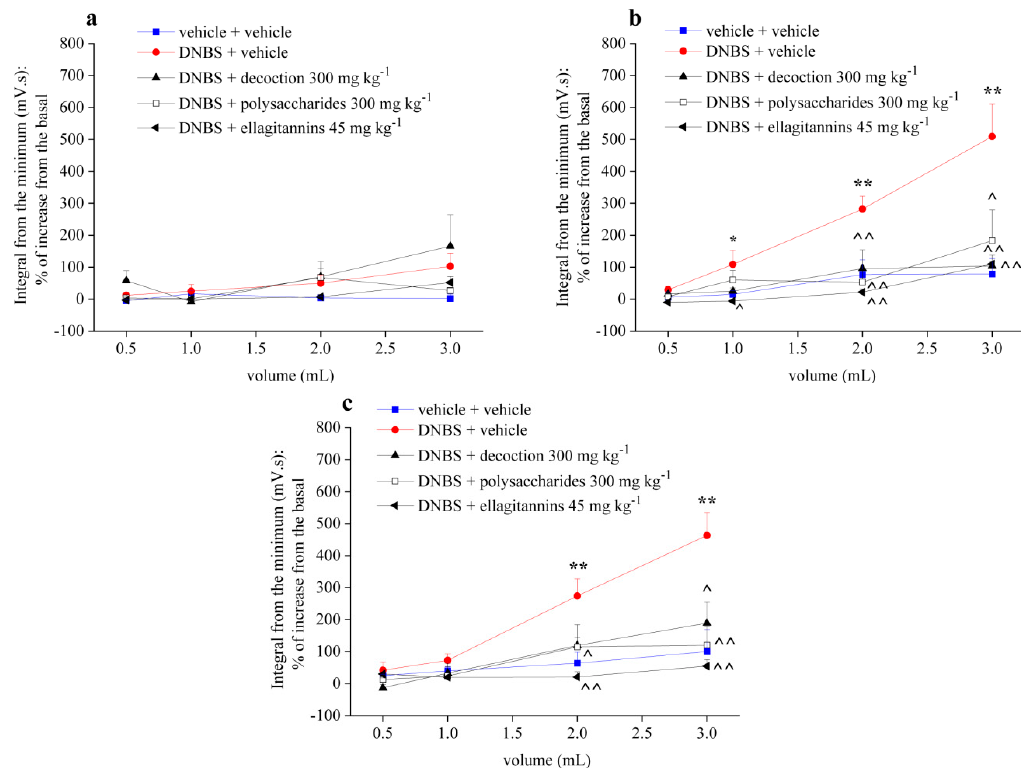
Figure 2. E ff ect of repeated treatment with pomegranate-based preparations on visceral hypersensitivity. Tests were performed before the treatments ( a ), 7 ( b ) and 14 ( c ) days after the damage induction, measuring the Visceromotor Response (VMR) to the Colorectal Balloon Distension (CRD). Each value is the mean ± S.E.M. and represents the mean of six rats per group. * p < 0.05 and ** p < 0.01 vs. vehicle + vehicle treated animals. ^ p < 0.05 and ^^ p < 0.01 vs. 2,4-dinitrobenzenesulfonic acid (DNBS) + vehicle treated animals.